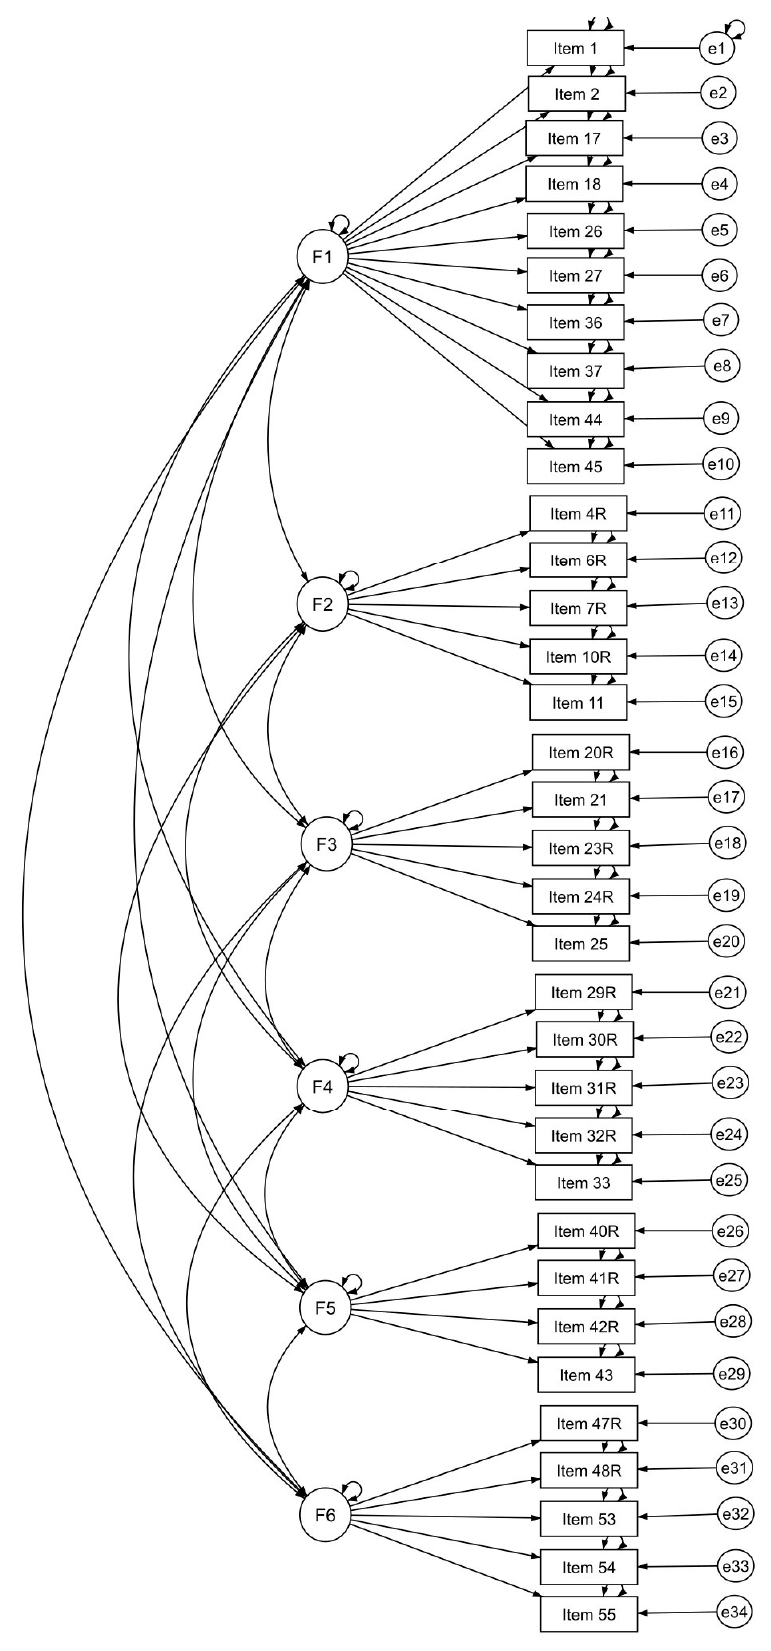
Figure 1. A priori model of the questionnaire structure with 6